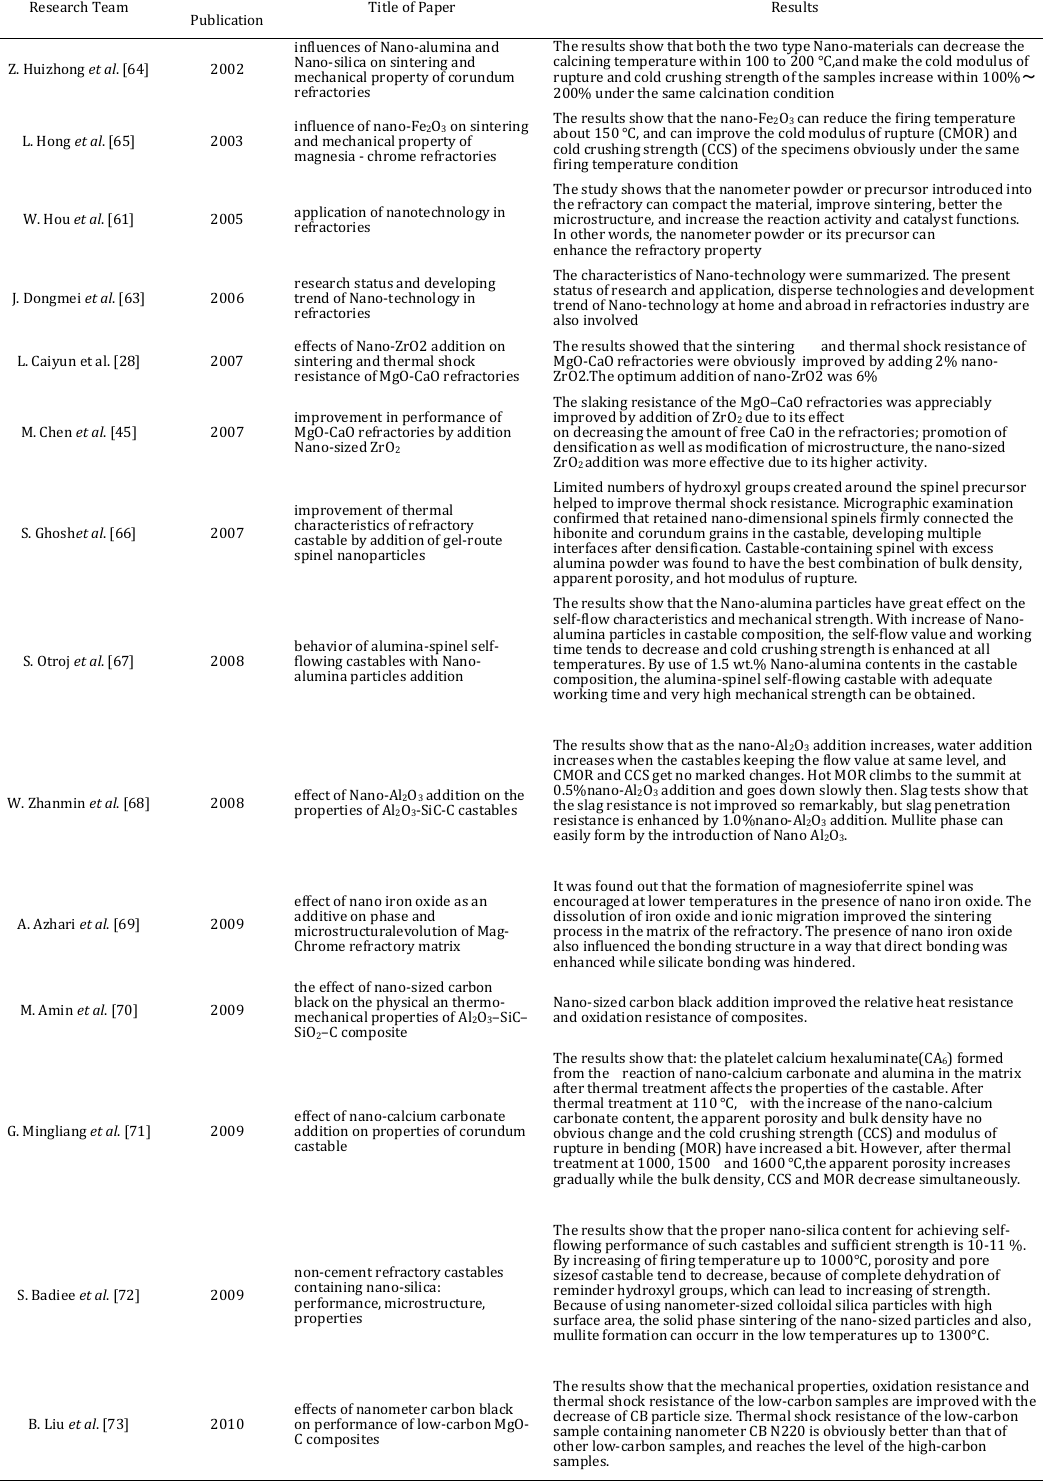
Table 2. Published articles with title the use and application of nano-particles additives in the refractories since 2002 -2016 Research Team